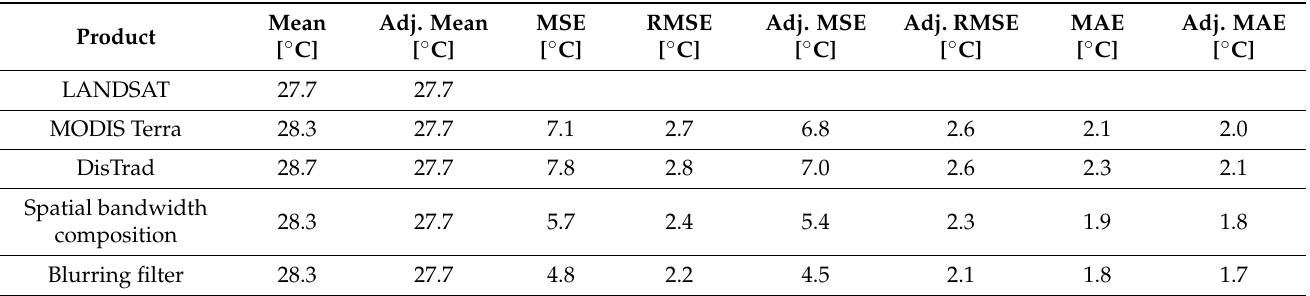
Table 3. Evolution of the mean squared error (MSE), root mean squared error (RMSE) and mean absolute error (MAE) during the processing steps. The “adjusted” indicators are used to remove the bias caused by differences in time of day.